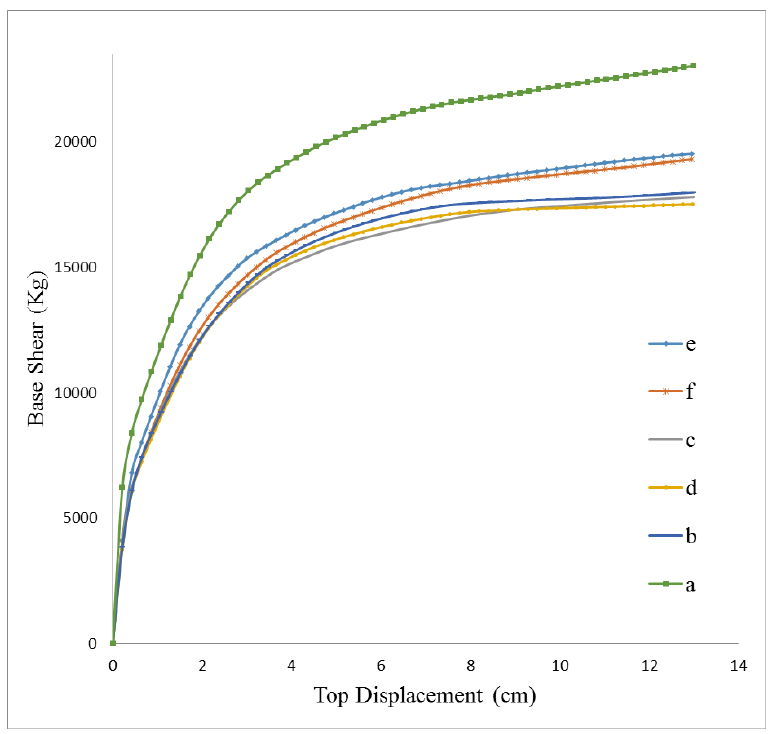
Figure 7. Load-displacement curves of specimens with different position of opening.